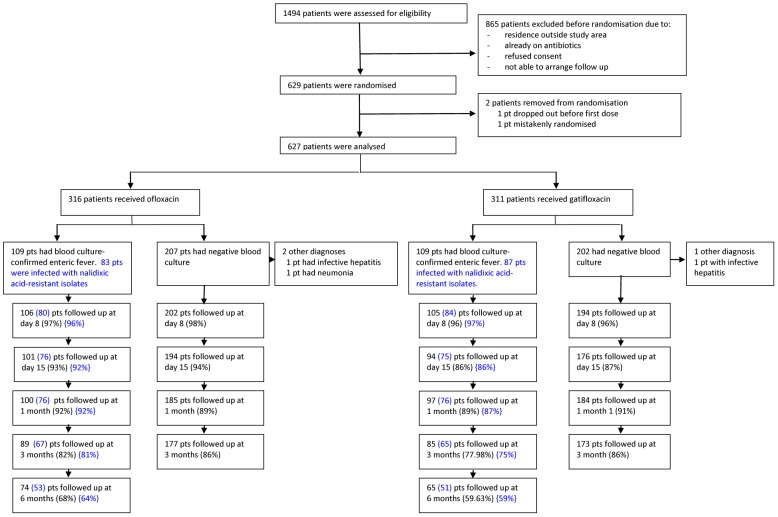
Trial profile.Numbers in blue font represent numbers of patients infected with nalidixic acid resistant isolates.